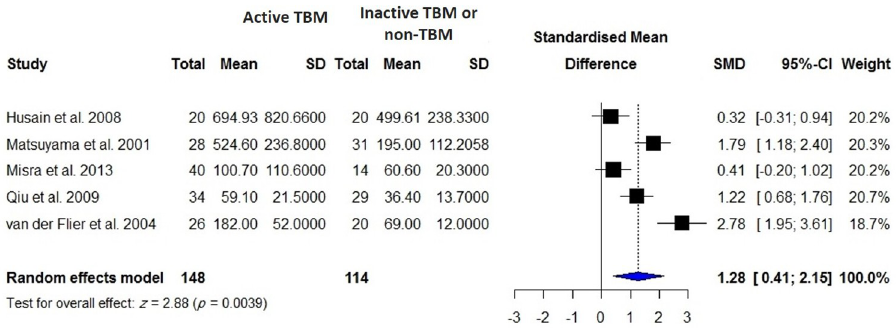
Fig 5. Meta-analysis of blood VEGF levels in patients with active TBM vs. controls including inactive TBM or non-TBM individuals.